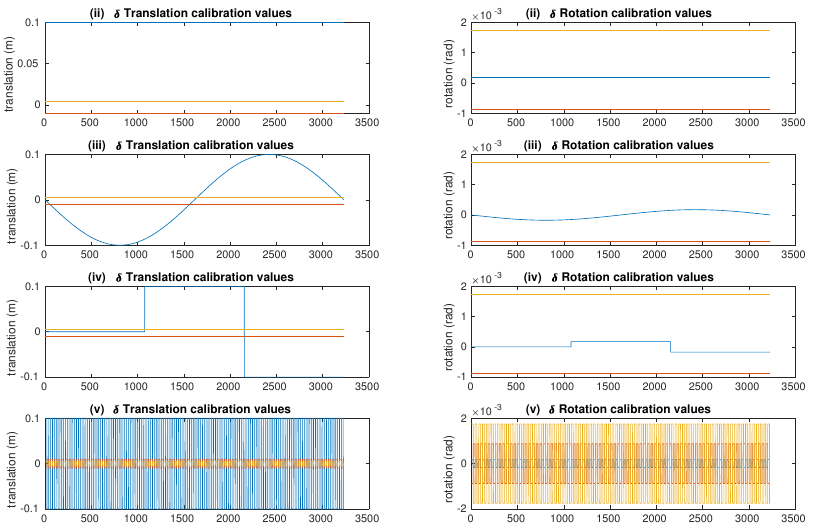
Figure 4. Ground truth δ error calibration value for the different experiments. Major effects of decalibration noise are applied on the t x translation (the baseline) and on the α z rotation (rotation around the baseline axis). Blue, red, and yellow are respectively the values for t x , t y , and t z and α x , α y , and α z